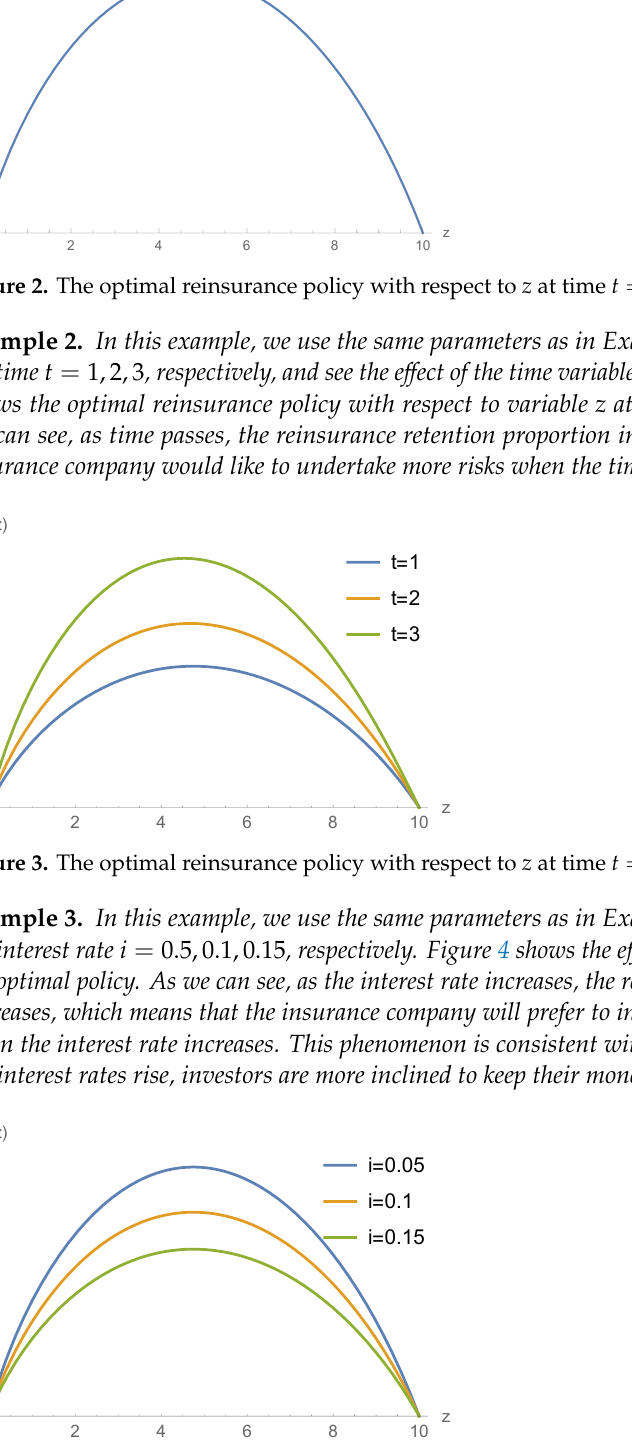
Figure 4. The optimal reinsurance policy with respect to z under di ff erent interest rates i = 0.05,